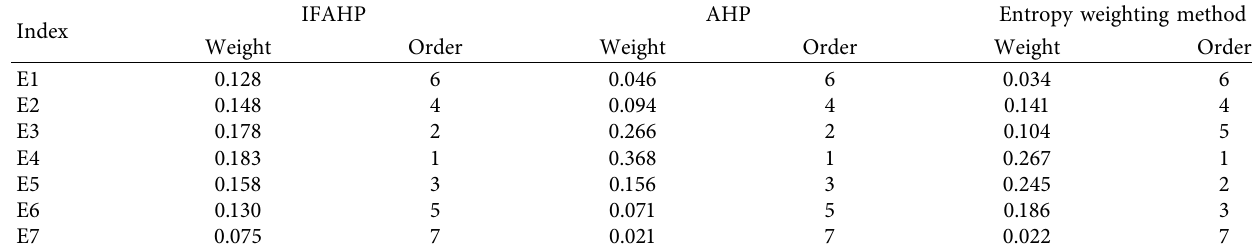
Table 11: Calculation results of different weighting